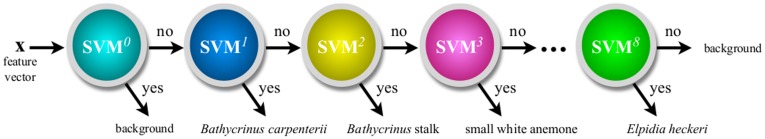
Successive classification with different SVMs.To prevent a time-consuming classification of each feature vector with all SVMs, the SVMs were ordered in a tree structure. The order of SVMs and the confidence thresholds as well as the blob sizes were tuned automatically according to the resulting Sensitivity and Positive Predictive Value.